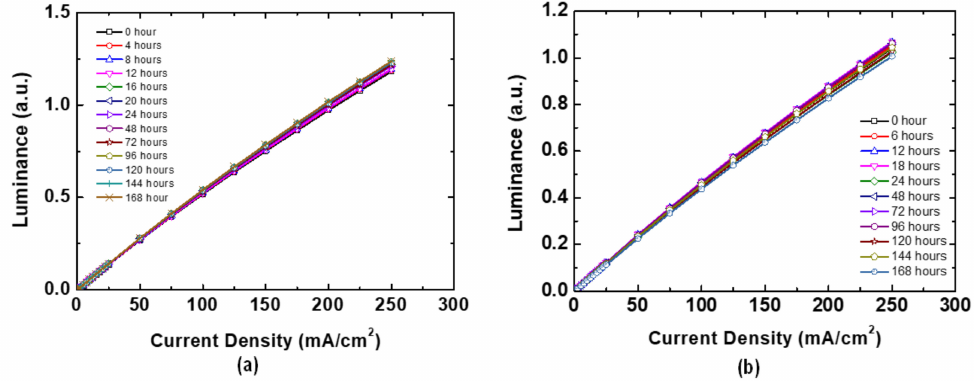
Figure 3. L-J curves under constant current stresses at ( a ) 2.5 × J D and ( b ) 15 × J D